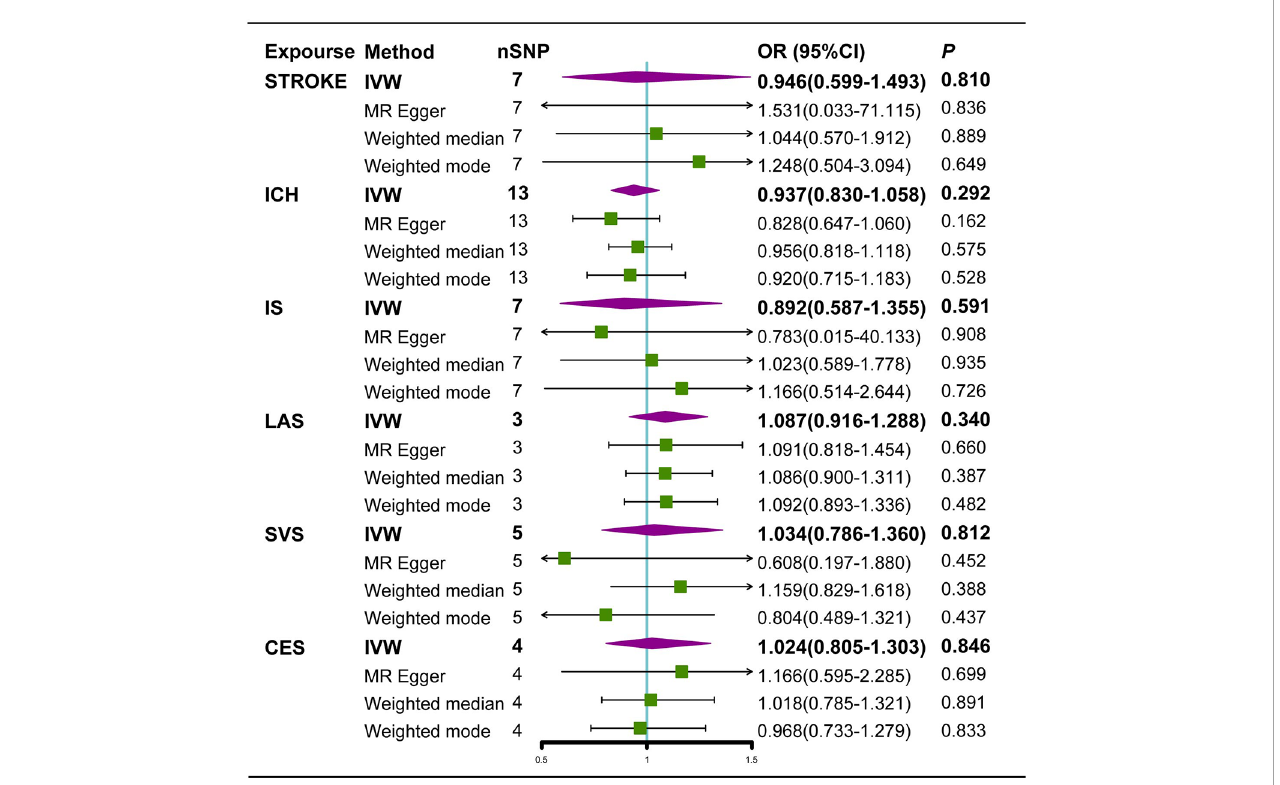
FIGURE 5 Estimated causal effects of stroke on AS using different MR methods. ICH, Intracerebral hemorrhage; IS, Ischemic stroke; LAS, large artery atherosclerosis; SVS, small vessel stroke; CES cardioembolic stroke; Cl, con fi dence interval; IVW, inverse variance weighted; MR-Egger, Mendelian randomization-Egger; SNPs, single nucleotide